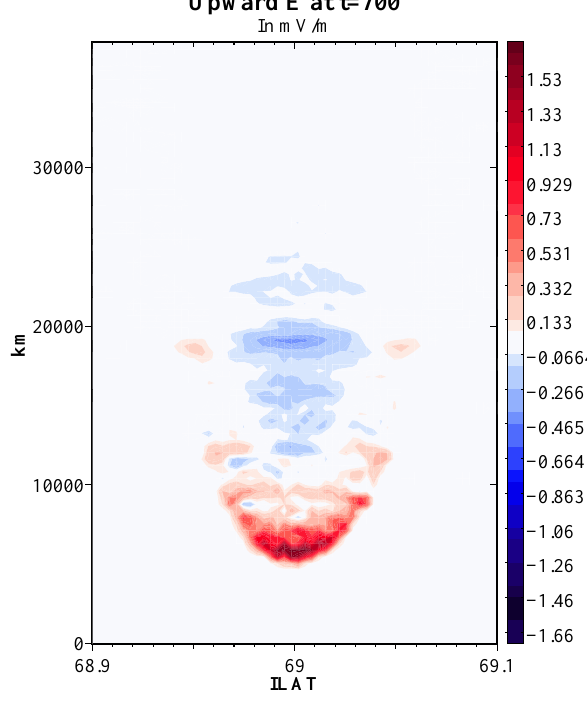
Fig. 7. Perpendicular (positive northward) electric field at t = 700s.